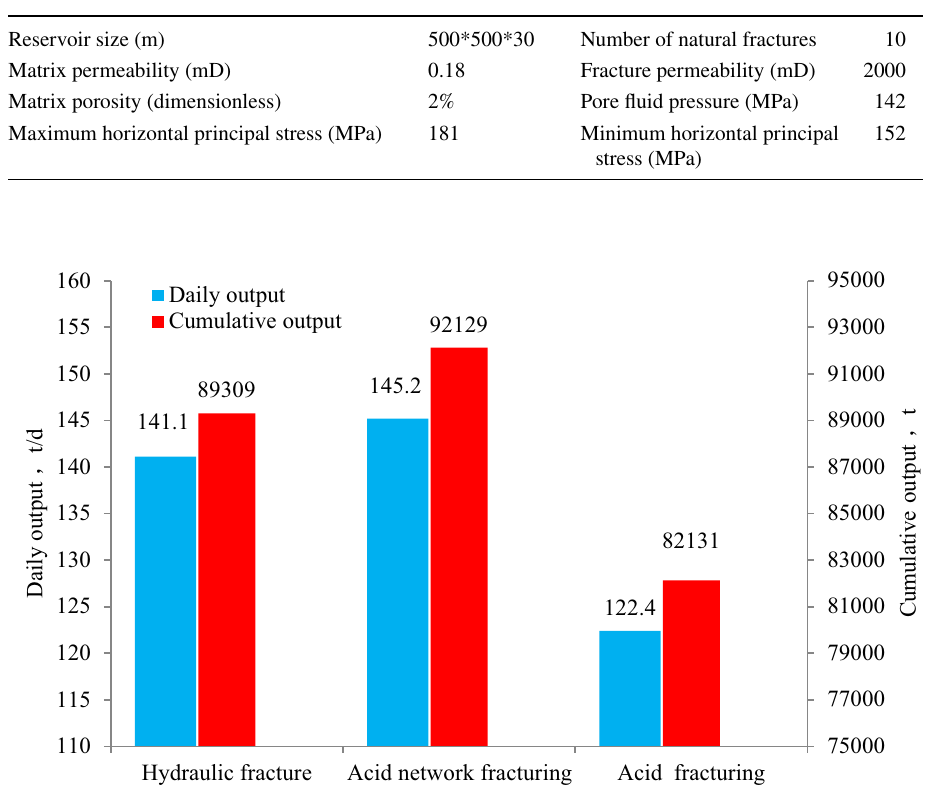
Table 2 Main parameters used in numerical simulation